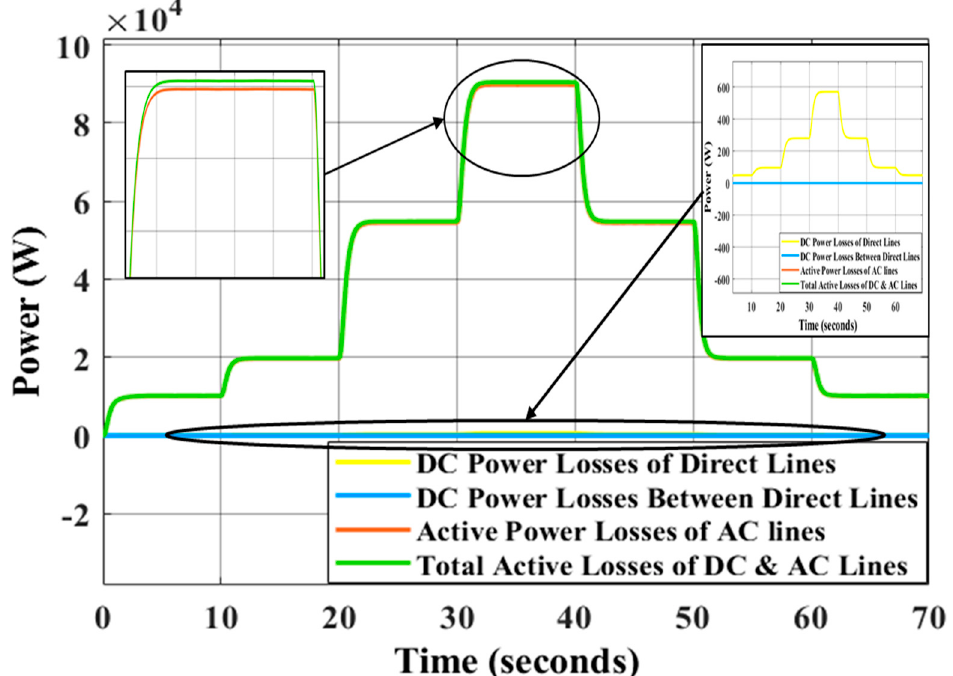
Figure 17. Active power losses of MG under the changing of load conditions using high resistances for AC lines.